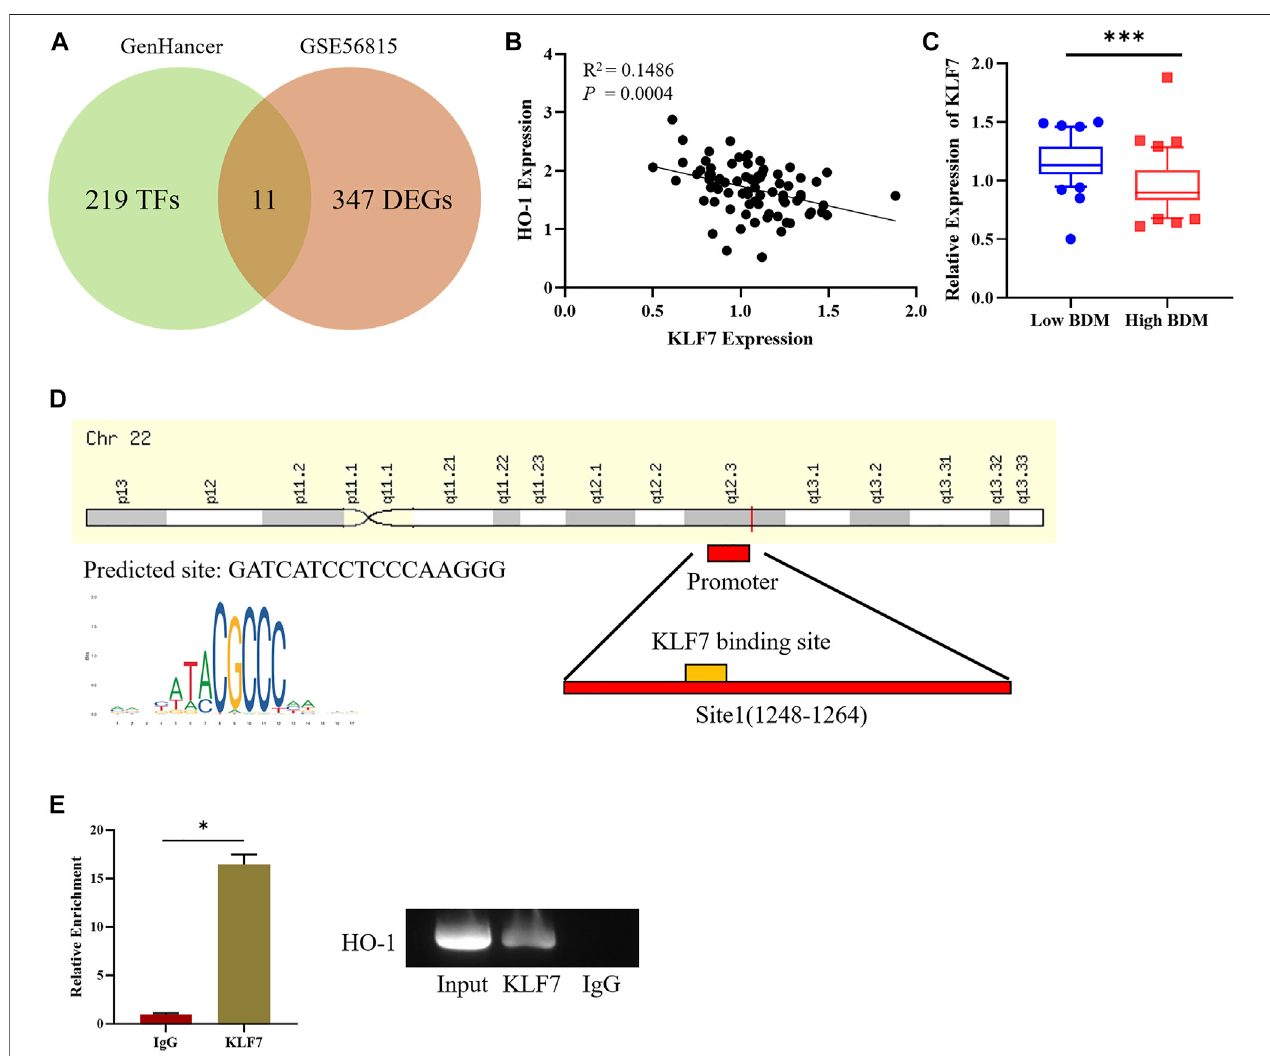
FIGURE 2 | KLF7 is an upstream regulator of HO-1. (A) Venn plot for screening DE-TFs in osteoporosis. (B) Correlation analysis between KLF7 and HO-1 expressions. (C) KLF7expressioninhigh/lowBDMpopulation. (D) PredictedKLF7bindingsitesonHO-1TSS. (E) ChIPandqPCRassaysoftheenrichmentofKLF7on the HO-1 promoter region. * p < 0.05, *** p <